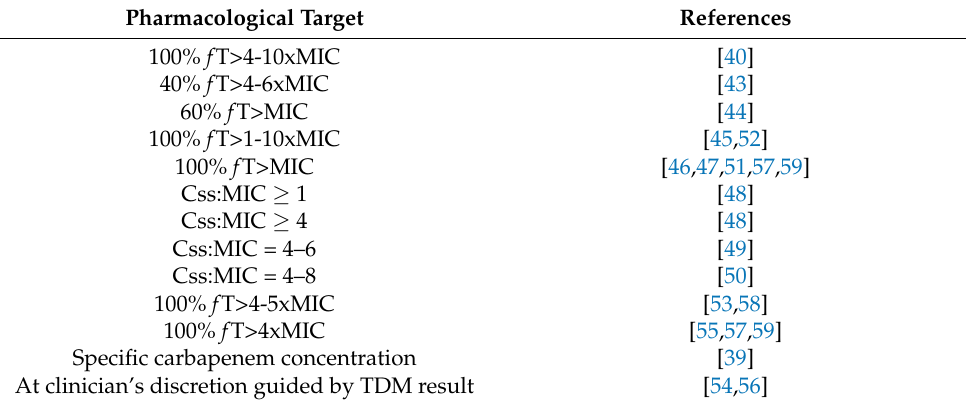
Table 3. Pharmacological targets of RCTs and cohort studies.